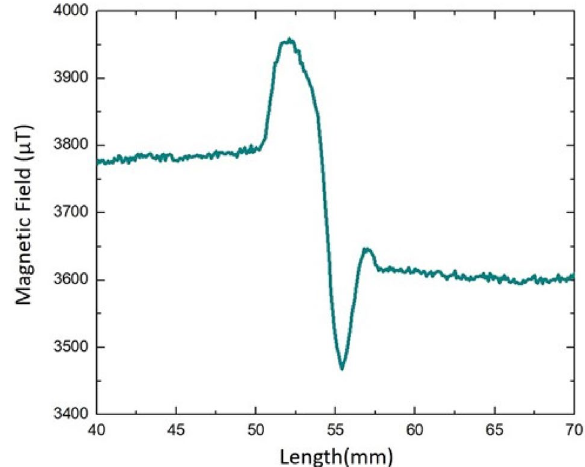
Fig. 14 Experimental result of magnetic field Y of a rectangular defect A1 with ordered magnetic